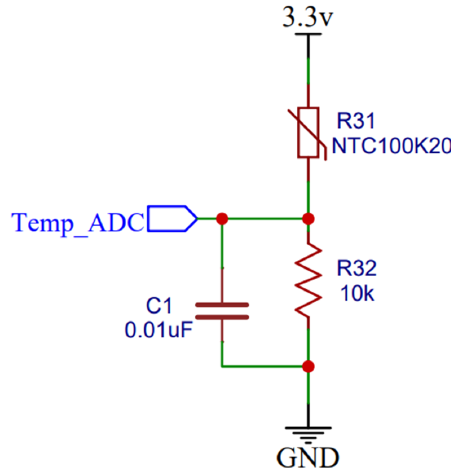
Figure 6. Temperature measurement